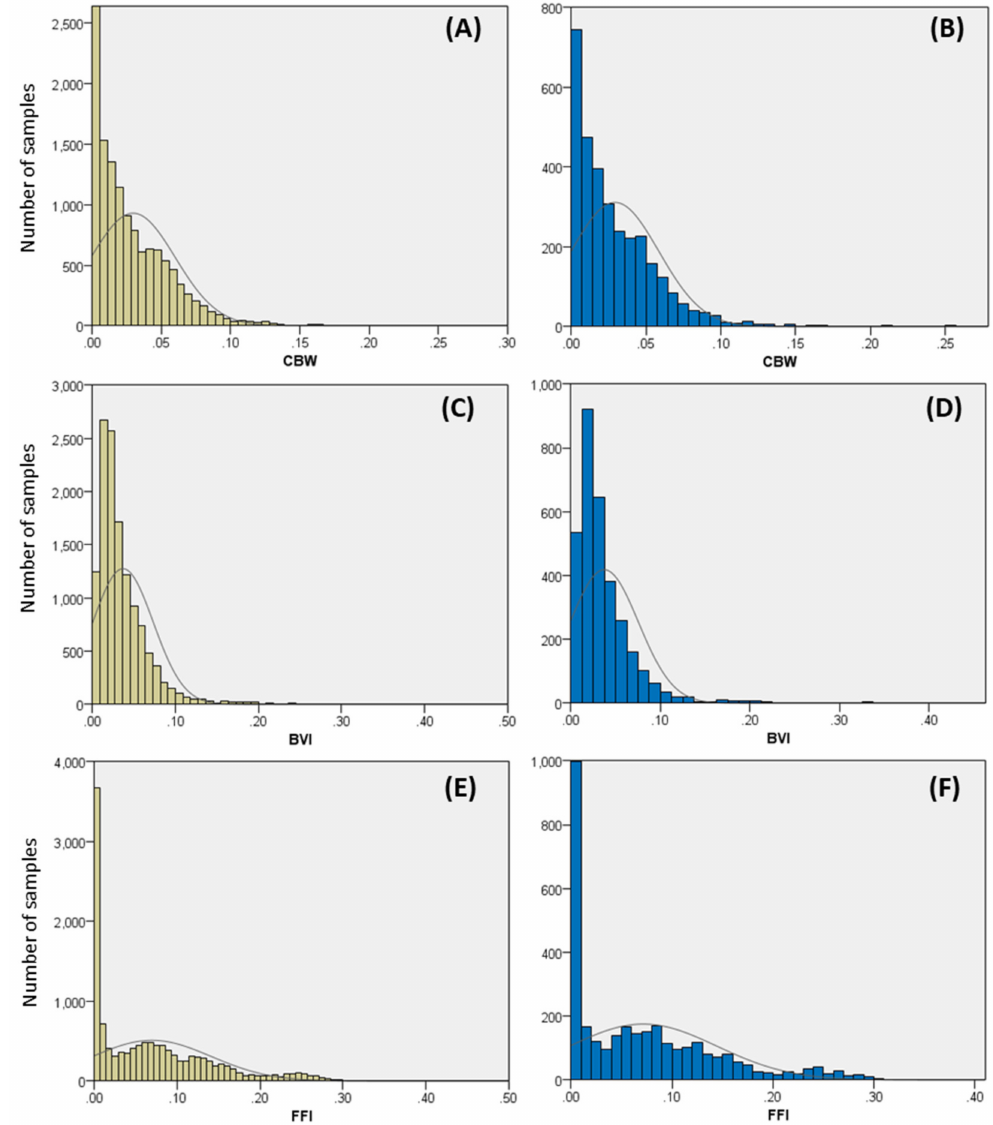
Figure 3. CBW, BVI, and FFI distribution in training (left histograms) and blind datasets (right